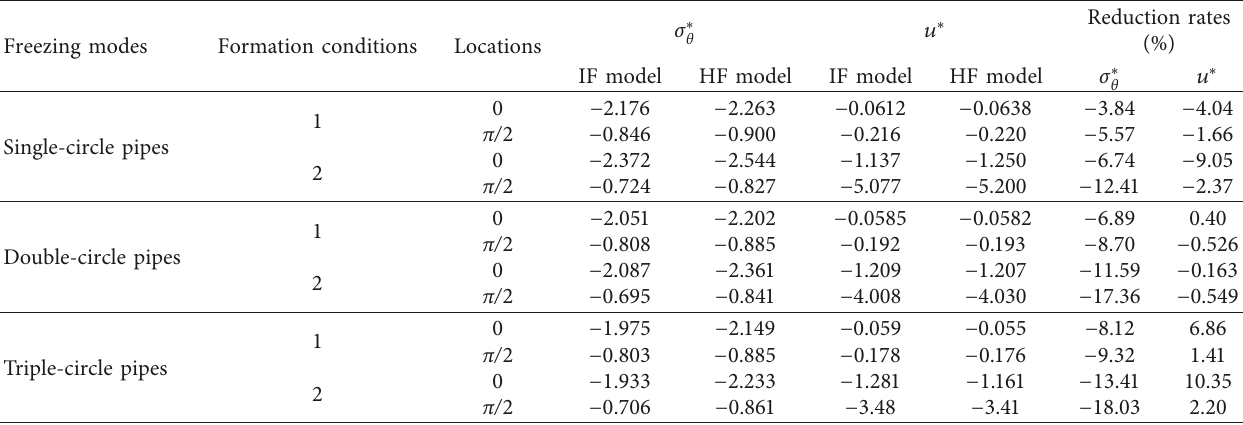
and radial displacement u ∗ of the inner edge for the IF model and HF model under different freezing θ